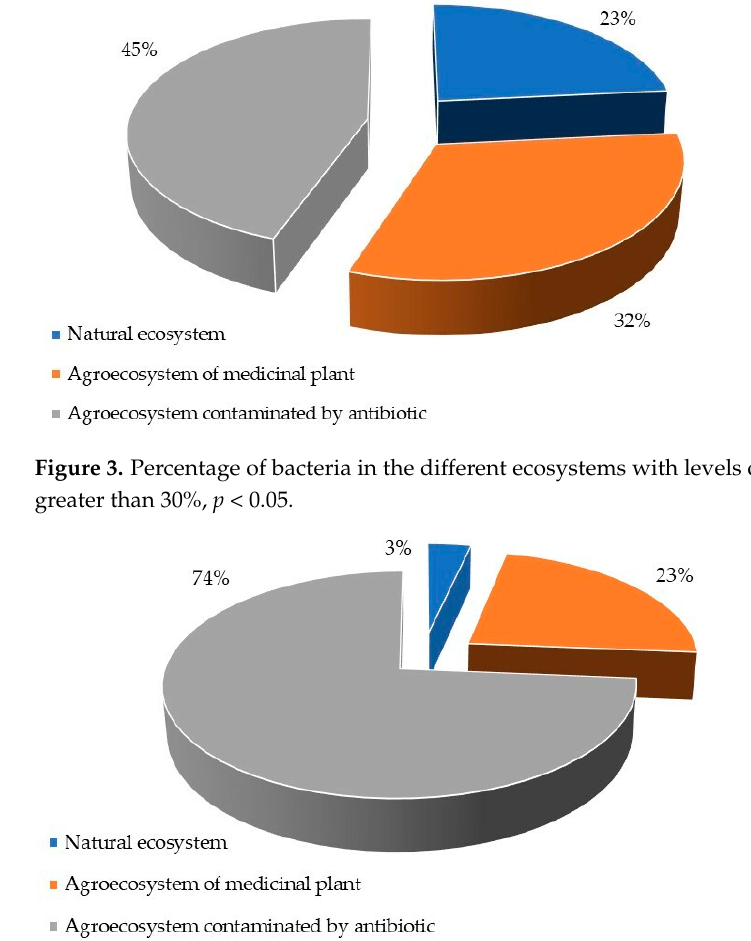
Figure 4. Percentage of bacteria in the different ecosystems with levels of AR for tested antibiotics greater than 70%, p < 0.05.